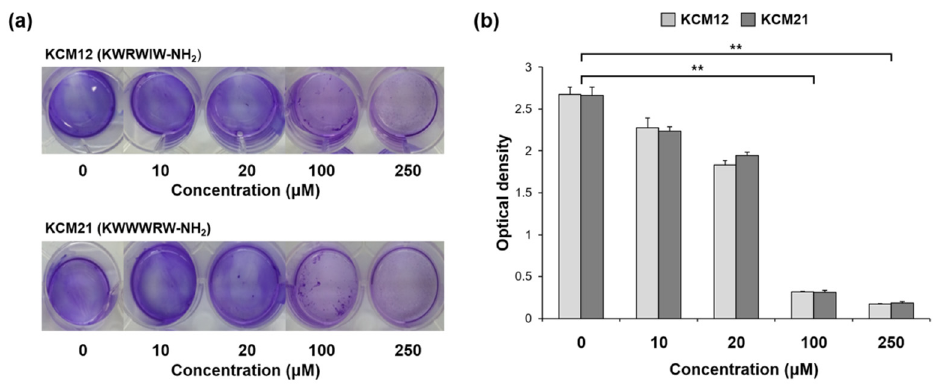
Figure 3. Antibiofilm effect of hexapeptides against Pst DC3000 biofilm ( a ) Images of biofilm formation capacity using crystal violet (CV) staining and ( b ) biofilm mass measurements after hexapeptide treatment of Pst DC3000, (* significant at p ≤ 0.05 between control (0 µM) and KCM12-